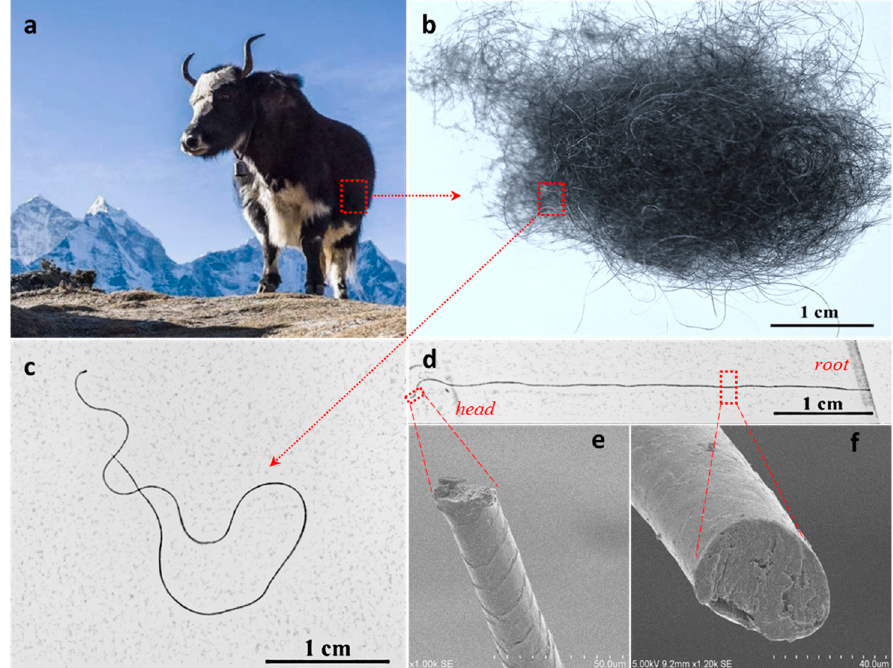
Figure 1. Yak living in a cold plateau area with thick, warm fur and hair layers, ( a ) photograph of a yak living at Tibet plateau of more than 4000 m above sea level, ( b ) raw yak hairs with guard and down hairs, ( c ) a yak hair with natural crimps, ( d ) the stretched yak hair with more times in length than natural length, ( e ) cross section of head part of hair, and ( f ) root coarse part of hair.